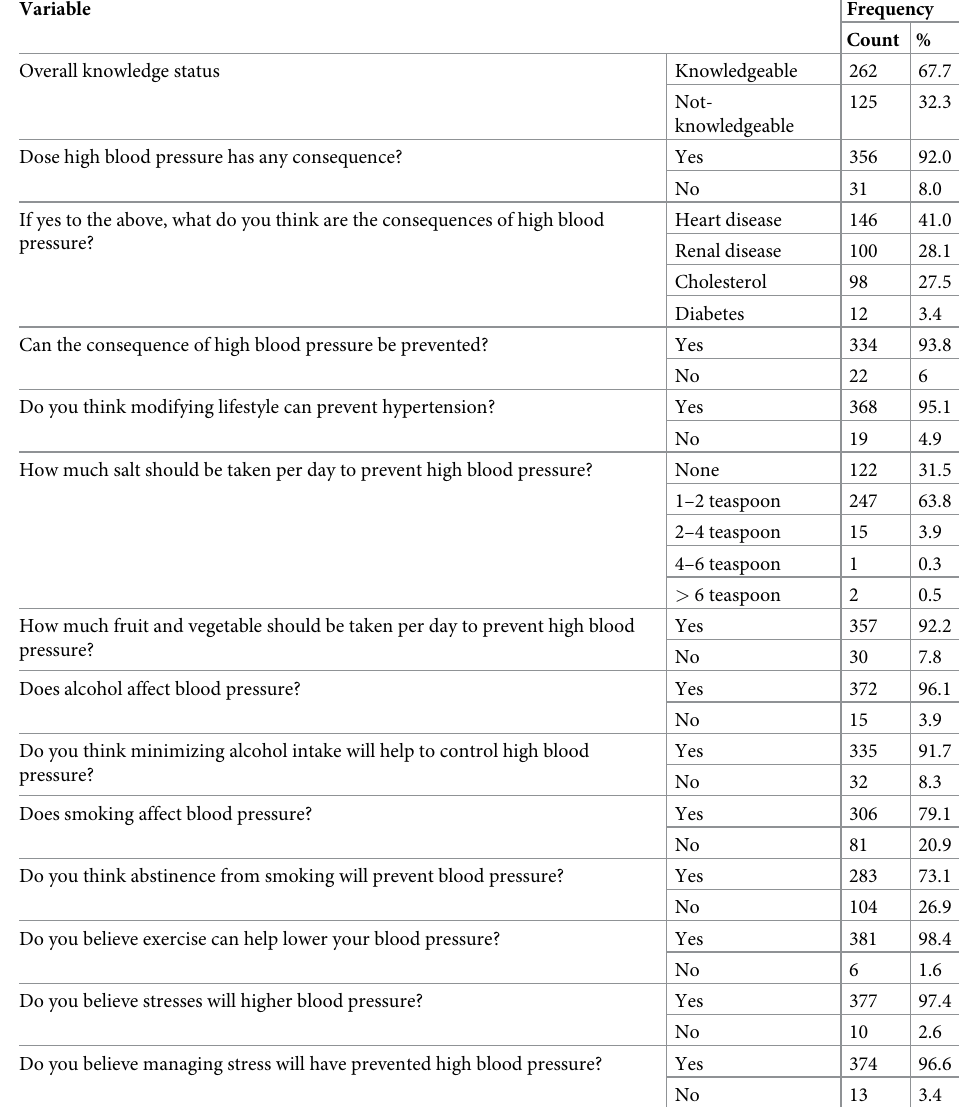
Table 4. Knowledge of hypertensive patients on treatment follow up regarding lifestyle modification at Yekatit 12 General hospital in 2019 (n = 387).